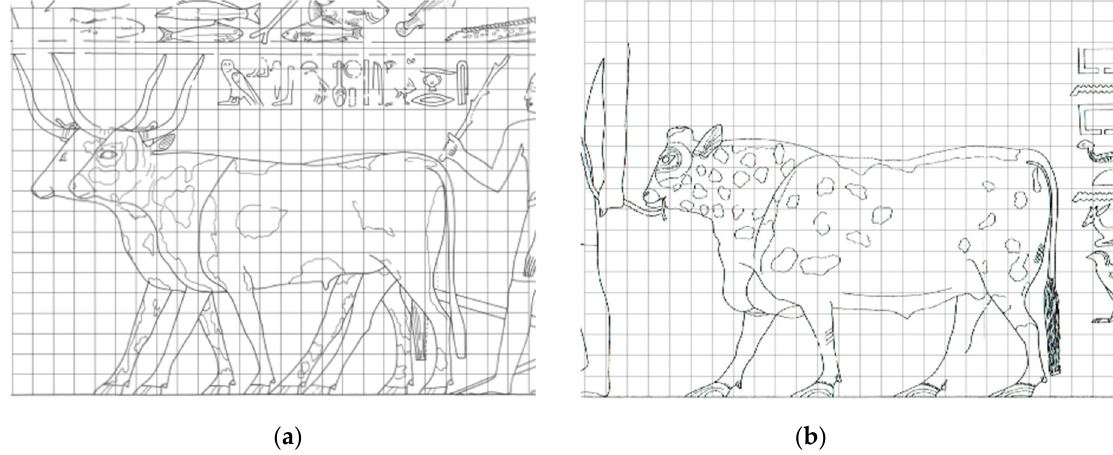
Figure 2. ( a , b ) Cattle figures from the Meir tomb of Senbi (Tomb B1) (left) and tomb of Khnumhotep II (Tomb 3) at Beni Hassan (right) with the hypothetical Meir grid applied by the author to show the position of the chest floor in relation to height of the animal. The oxen from the tomb of Senbi (B1) are an example of working cattle, depicted ploughing the fields. The right image from Khnumhotep II (Tomb 3) provides an example of non-working cattle, with the animal being lead towards the deceased as an offering (to be discussed in Section 3.2.2 below). Images: Kanawati and Evans (2017, pl. 79) and Kanawati and Evans (2014, pl. 105), respectively.